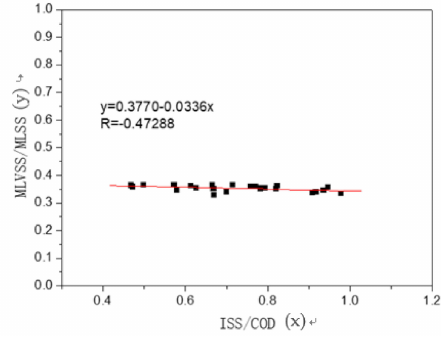
Figure 7. Correlation between ISS/COD and